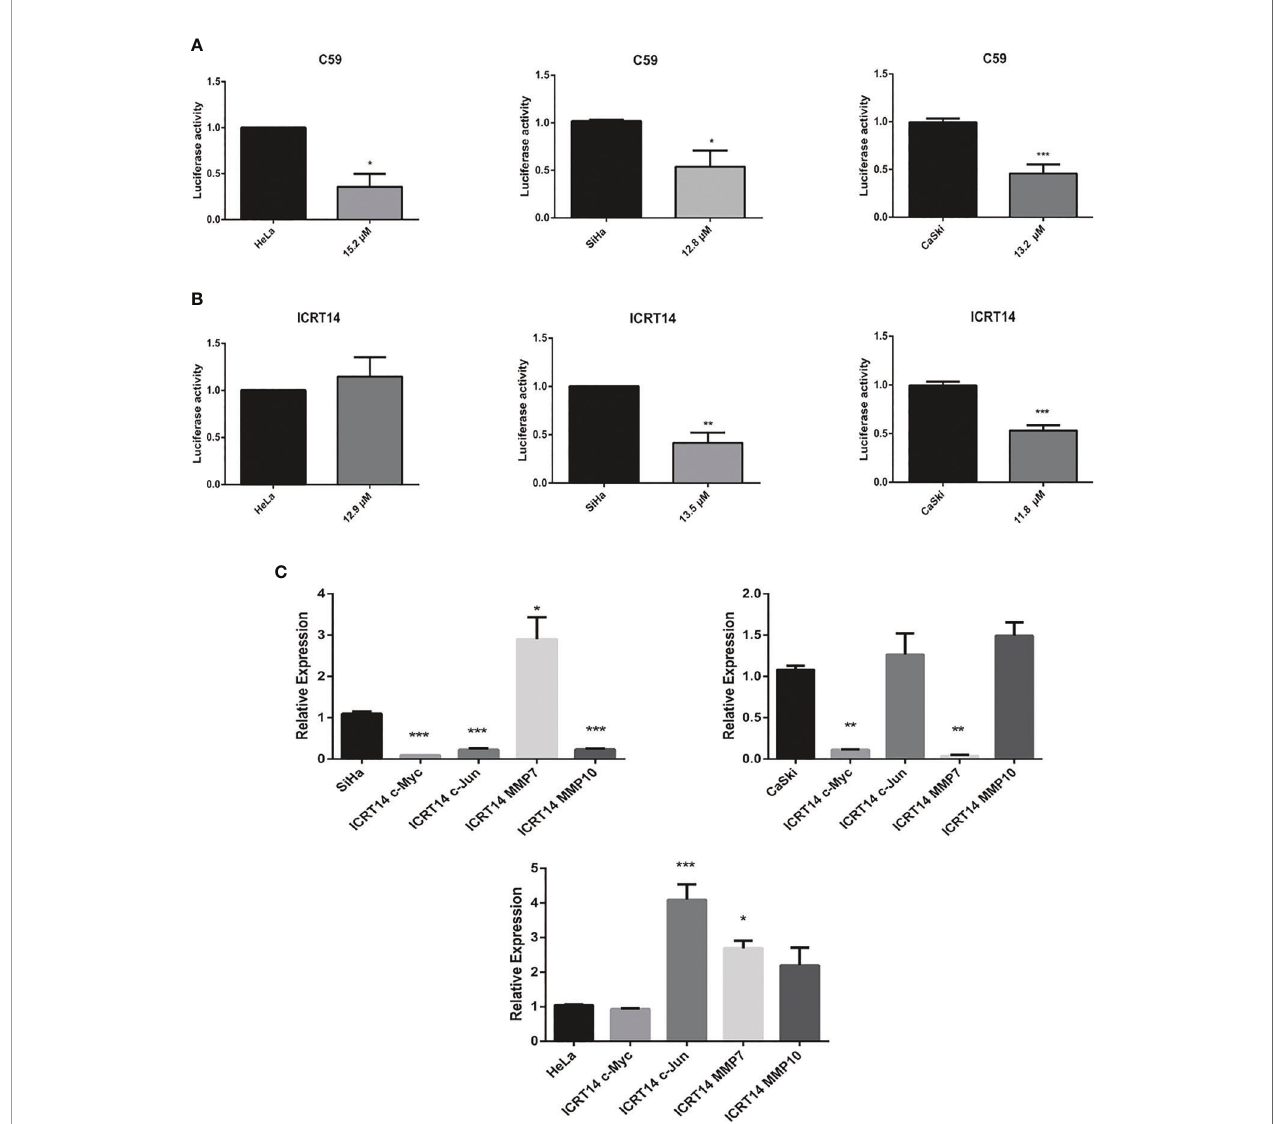
FIGURE 5 | Effect of C59 and ICRT14 drugs on Wnt/ b -catenin pathway in CC cell lines. HeLa, SiHa and CaSki cells were co-transfected with 2.5 m g FOPFlash-Luc (mutant reported vector) and TOPFlash (Wnt/ b -catenin reporter vector). After 24 hrs, they were incubated with IC50 of (A) C59 and (B) ICRT14. After 24 hrs, the luciferase activity and the expression of the main targets of wnt pathway was measured in order to determine the Wnt/ b -catenin pathway activation by luciferase assay (A, B) and (C) RT-qPCR, respectively. The bars represent the mean ± standard deviation from at least three independent experiments. *p < 0.05; **p < 0.01 and ***p <